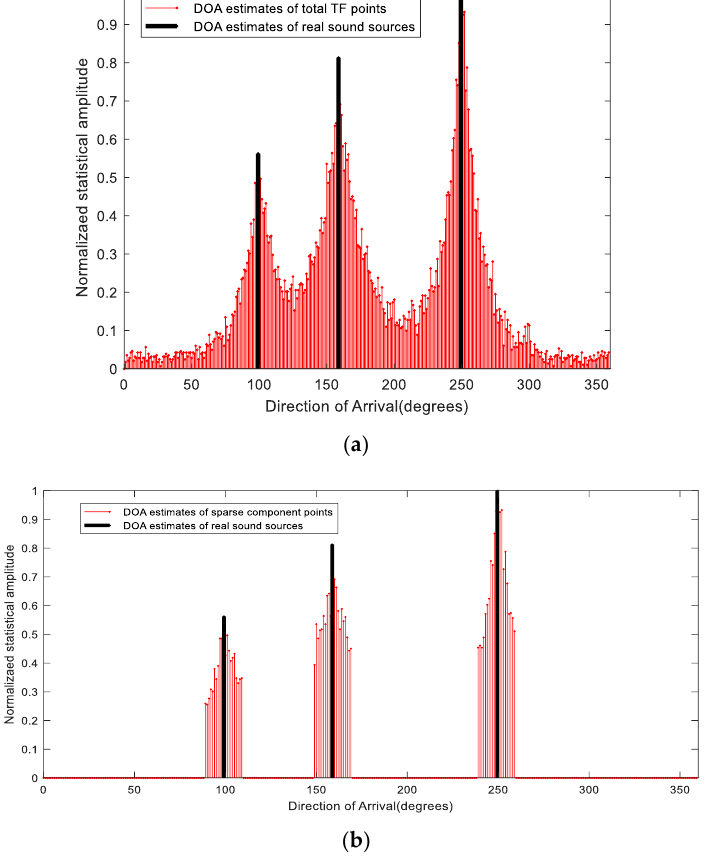
Figure 6. The normalized statistical histogram of DOA estimates: ( a ) is for total TF points; ( b ) is for sparse component